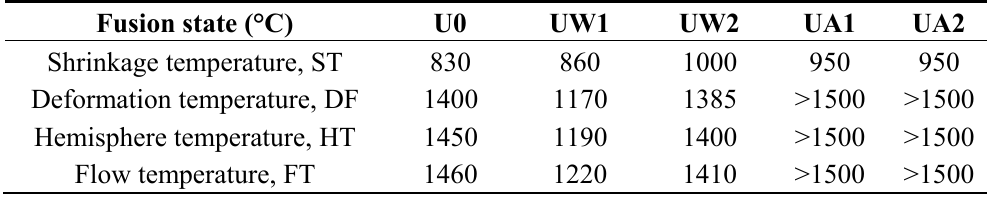
Table 3. Ash Fusion characteristics for untreated and treated biomass, and potential